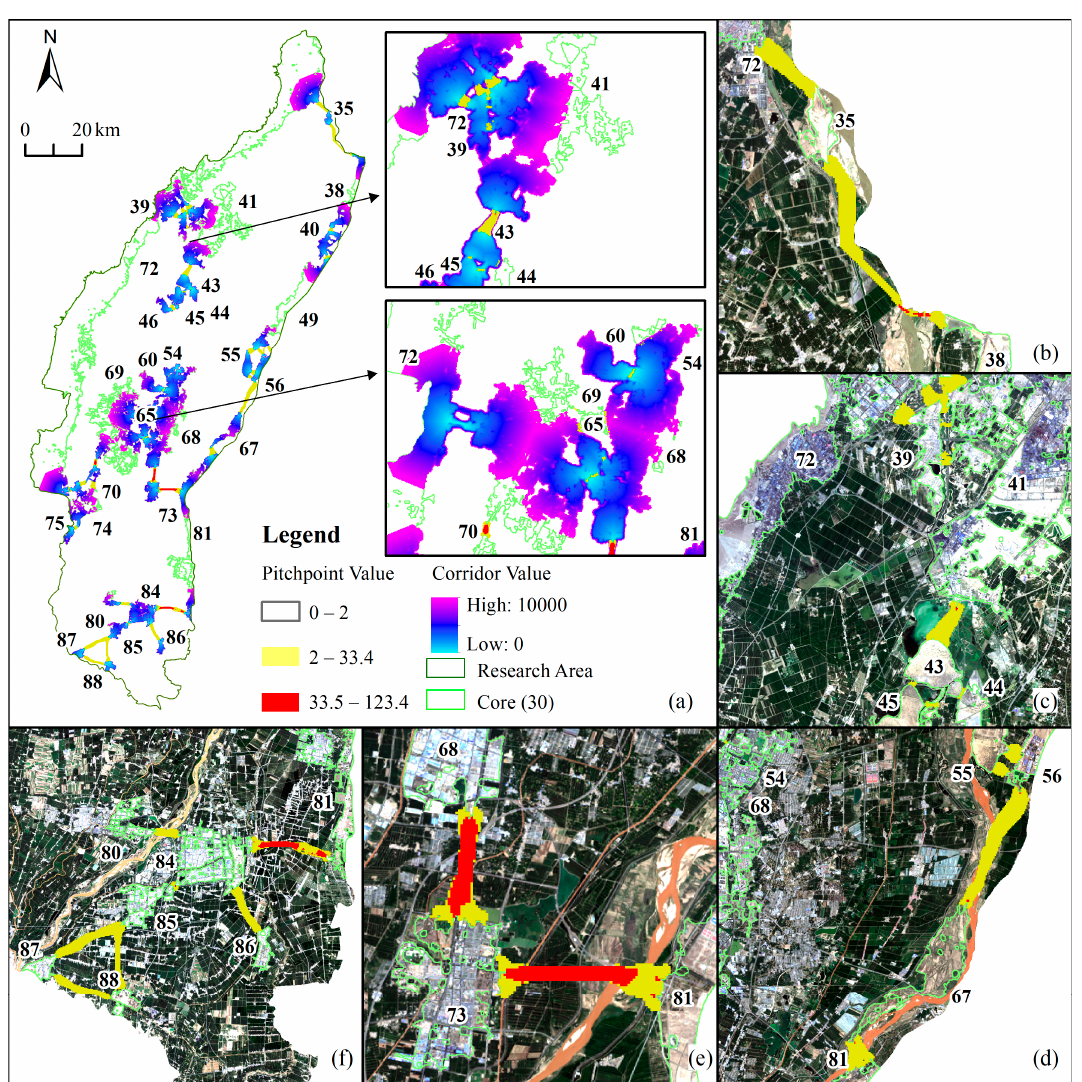
Figure 6. Spatial distribution of corridors and pinch points: ( a ) The distribution of a corridor and its effective resistance value are enlarged, with blue representing a smaller resistance value and rose-red representing a stronger resistance value. ( b – f ) The pinch point and its effective resistance value are enlarged, with yellow representing a smaller resistance value and red representing a stronger resistance value.